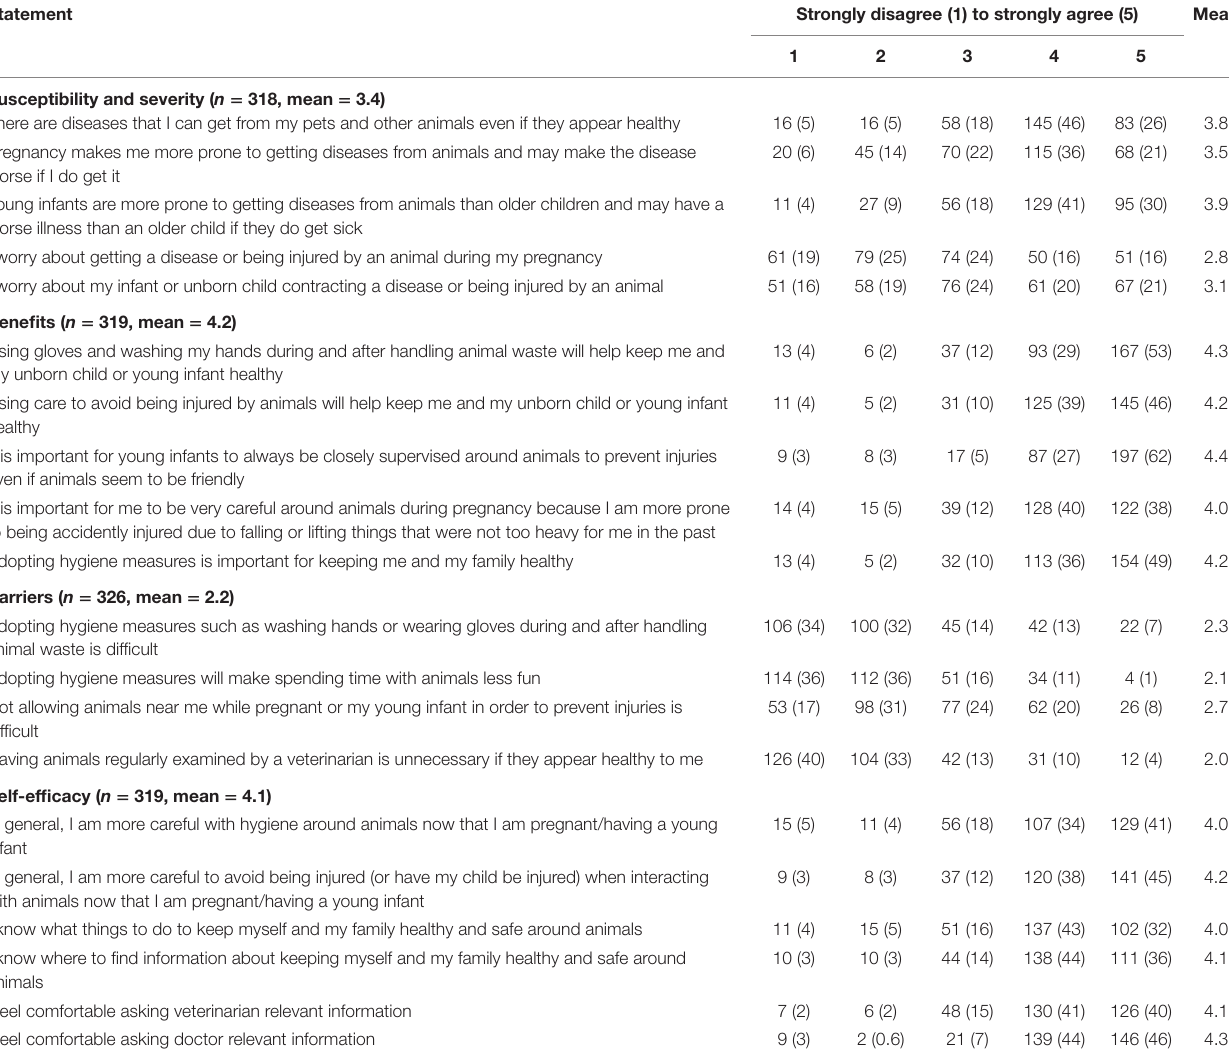
TaBle 1 | Perceptions toward animal contact and associated health outcomes in pregnant women and new mothers.